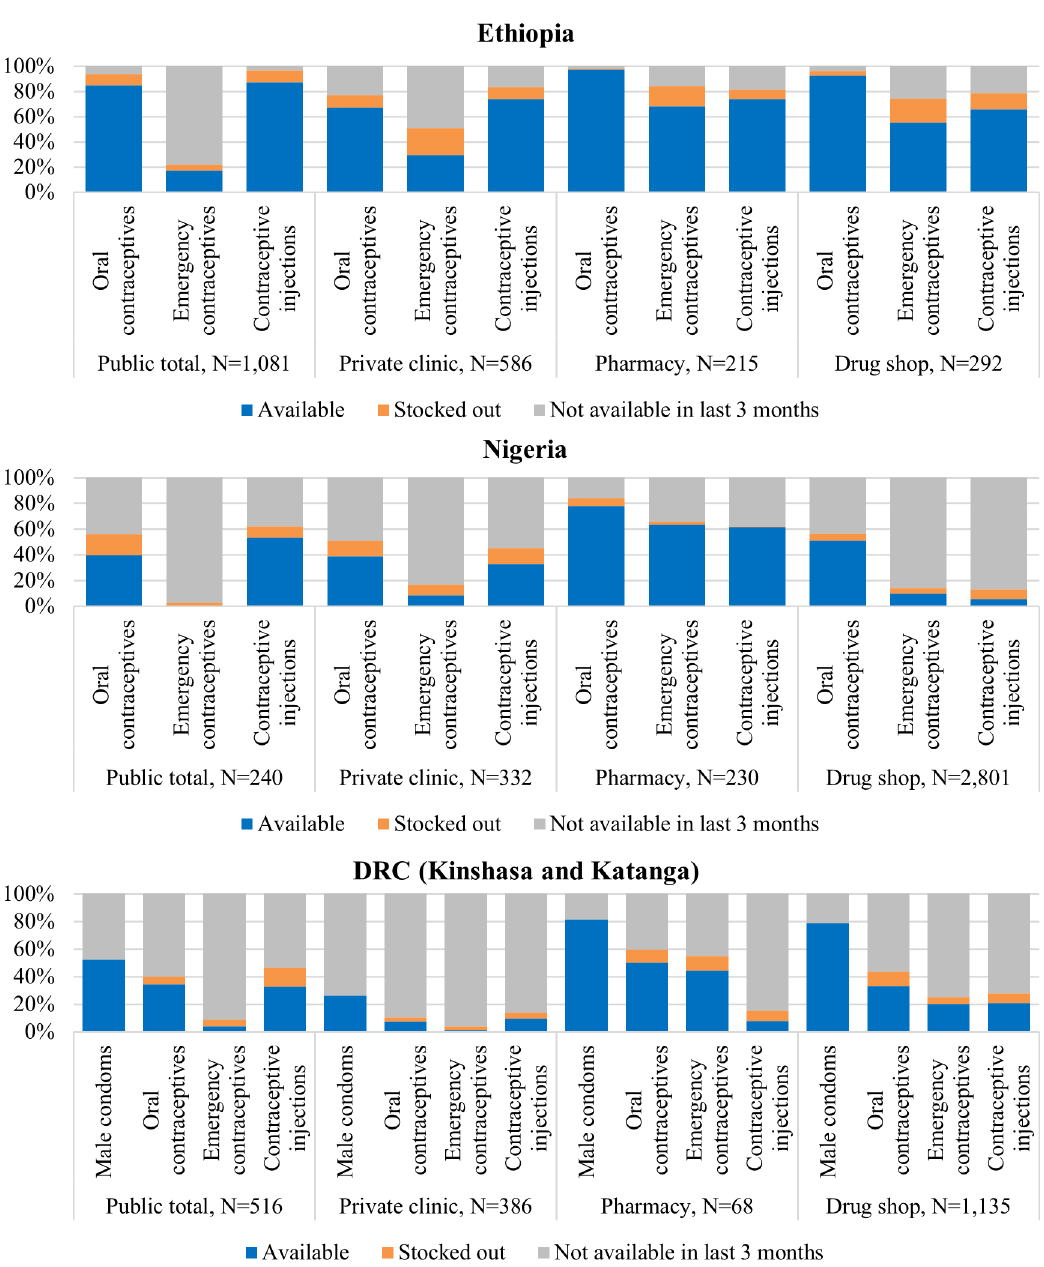
Fig 2. Availability of selected short-acting methods on the day of survey among all screened outlets excluding general retailers, by country and outlet type.